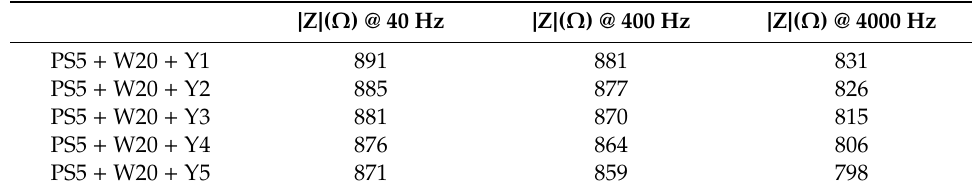
Table A17. The impedance amplitude for the biochip PS5 with the analyte at 40 Hz, 400 Hz and 4 kHz. (Figure A1). | Z | ( Ω ) @ 40